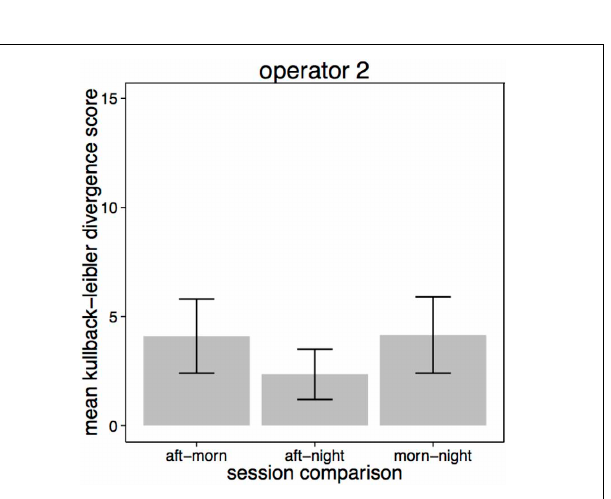
FIGURE 9 | Kullback-Leibler divergence score in screens selected for viewing on the multiplex by session for Operator